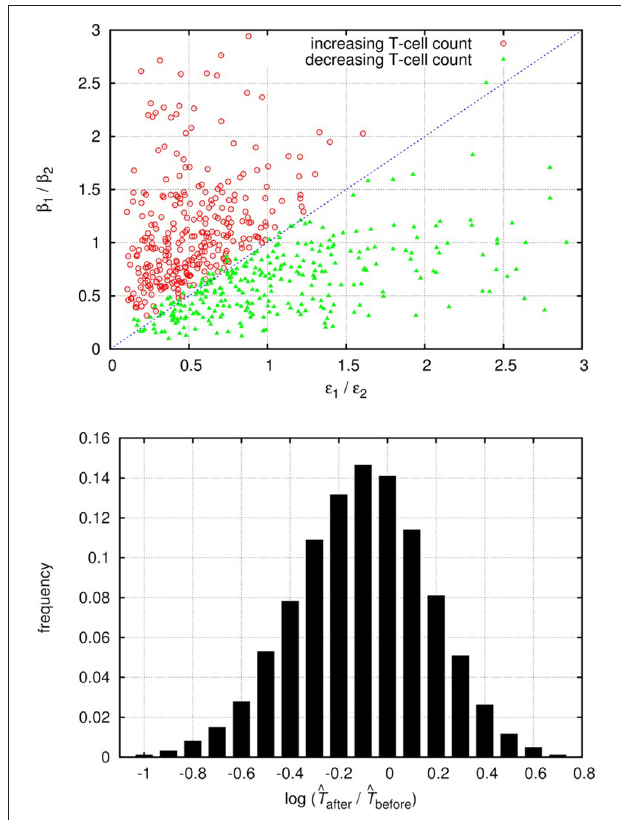
FIGURE 2 | The top panel shows the change in the uninfected target cell count after superinfection as a function of the relative differences in the interference ( ǫ ) and infection efficiency ( β ) parameters of both strains; results from 600 randomly selected simulation runs of the saturating infection dynamics model (300–300 runs with both increasing and decreasing cell counts) are shown. Red circles represent runs with increasing uninfected target cell count; green triangles represent runs with decreasing cell counts. = β 1 β ; Equation (24) is The blue dashed line of the diagonal corresponds to ǫ 1 ǫ 2 2 fulfilled above the diagonal. In all runs we set σ = 10 cells per day and δ T = 0.1 per day; all other parameters were drawn randomly with uniform distribution from the intervals presented in Table A5 (Appendix). The lower panel shows the histogram of the (log-transformed) ratios of the uninfected target cell counts after and before superinfection, from 20,000 simulation runs with successful superinfection.